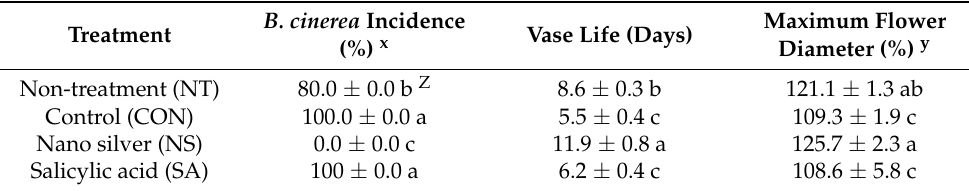
Table 1. Infection rate, vase life, and flower opening of cut rose flowers after B. cinerea inoculation.